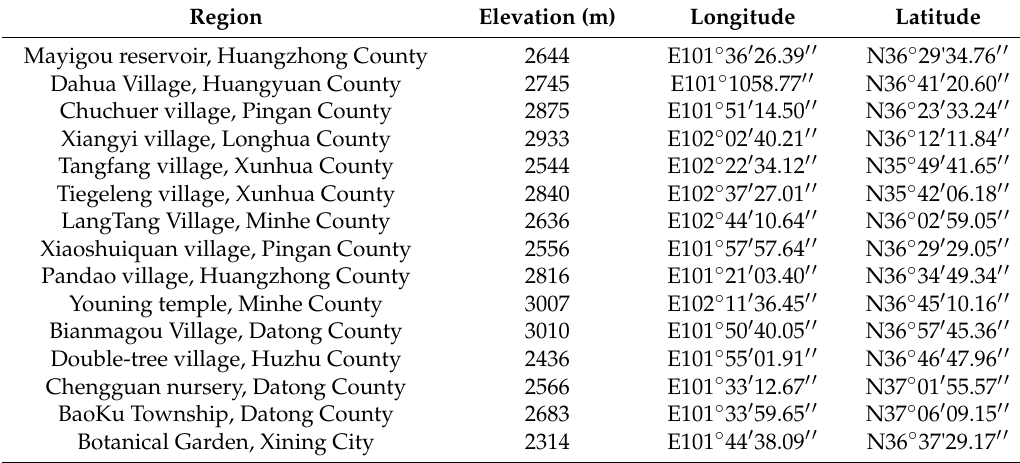
Table 1. Information of the collected H. rhamnoides L. sample in the province of Qinghai. Region Elevation (m) Longitude